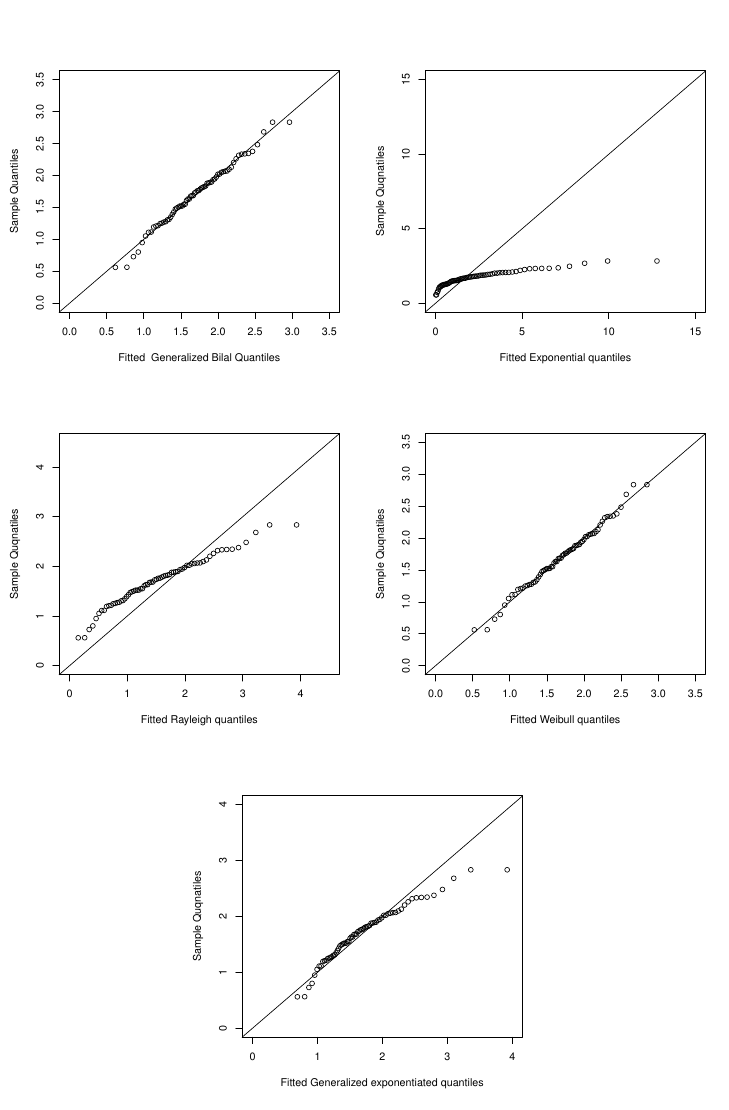
Figure 1 – Q-Q plot of various reliability models for the real data set